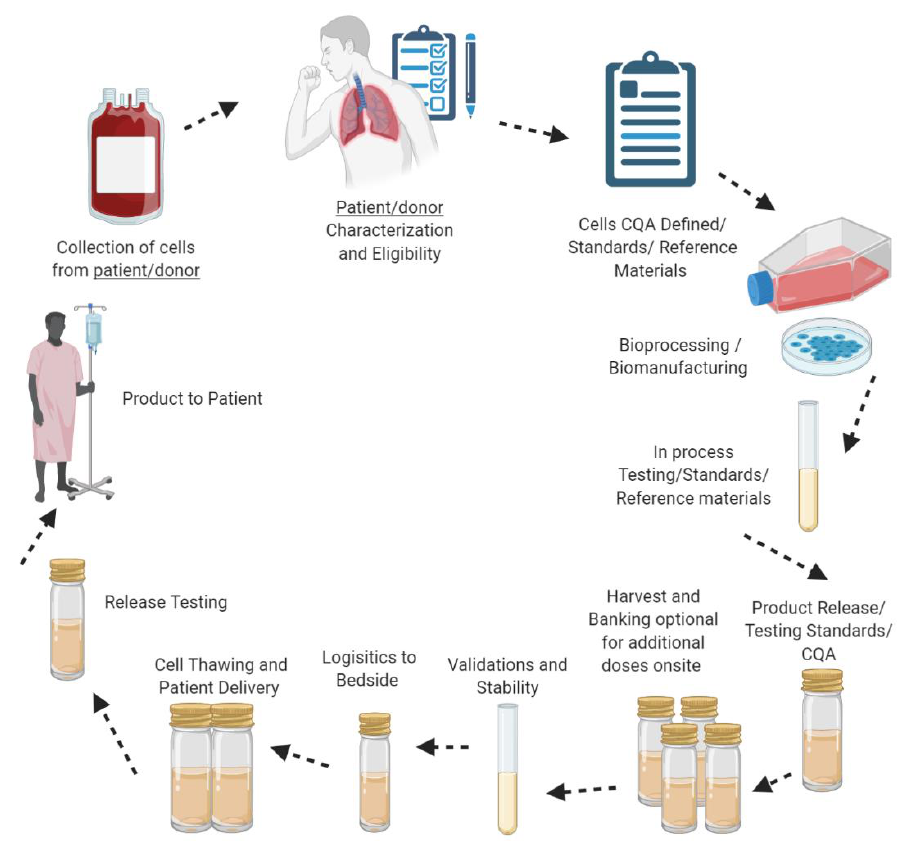
Figure 4. Overview of the production/manufacturing process of autologous and allogeneic cell therapy approaches. Note: Figure created with BioRender.com.